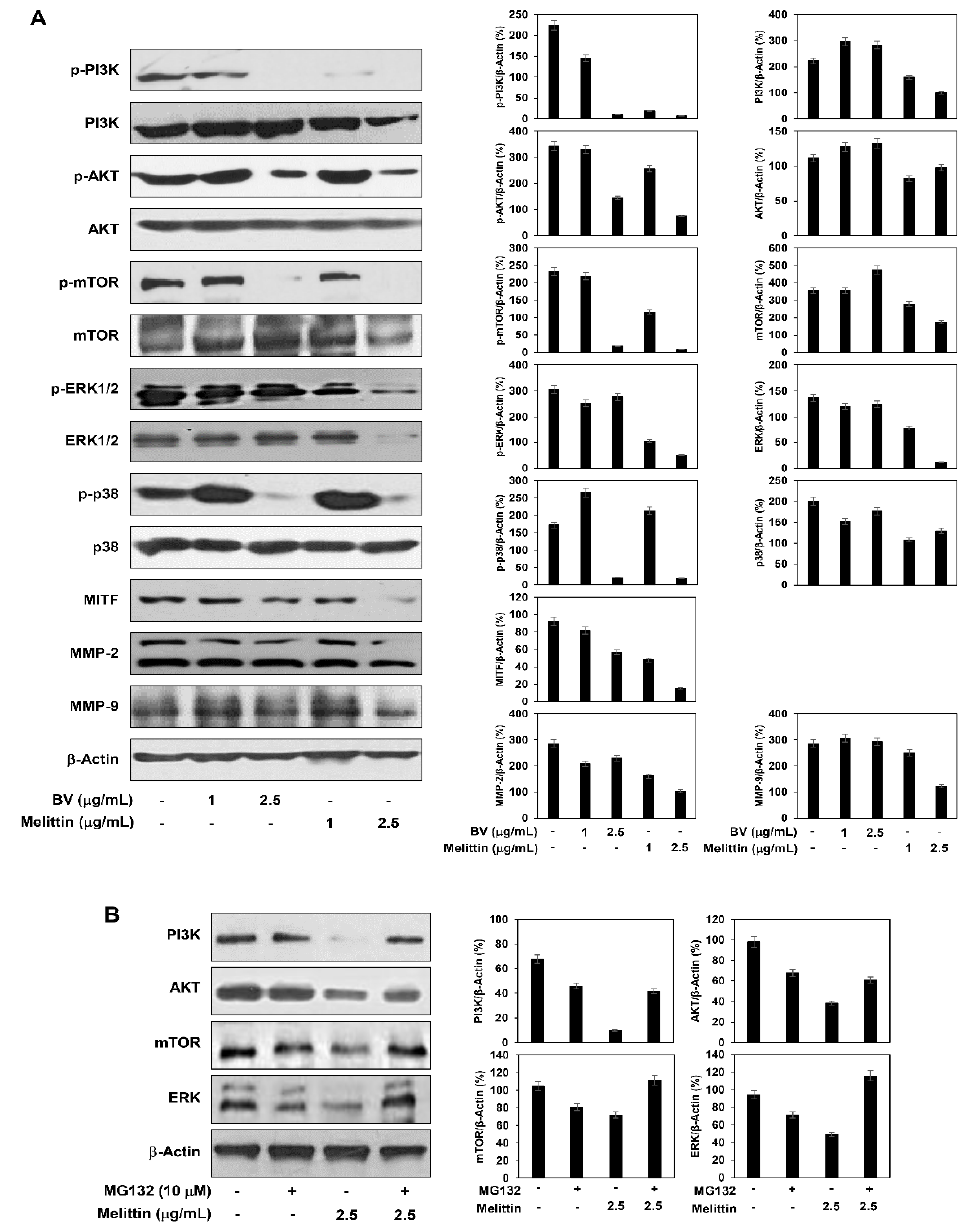
Figure 8. The effect of BV and melittin on the regulation of PI3K/AKT/mTOR and MAPK pathways. A375SM melanoma cells were treated with ( A ) BV, melittin and ( B ) MG132, and the protein levels were detected by Western blot analysis using specific antibodies. The levels of β-actin were used as an internal control. Each value represents the mean ± SE from three independent experiments.